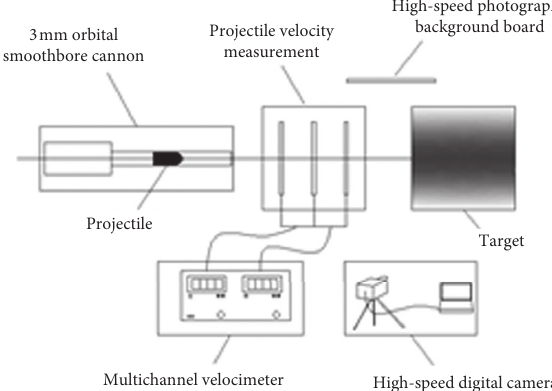
Figure 4: Penetration experiment schematic